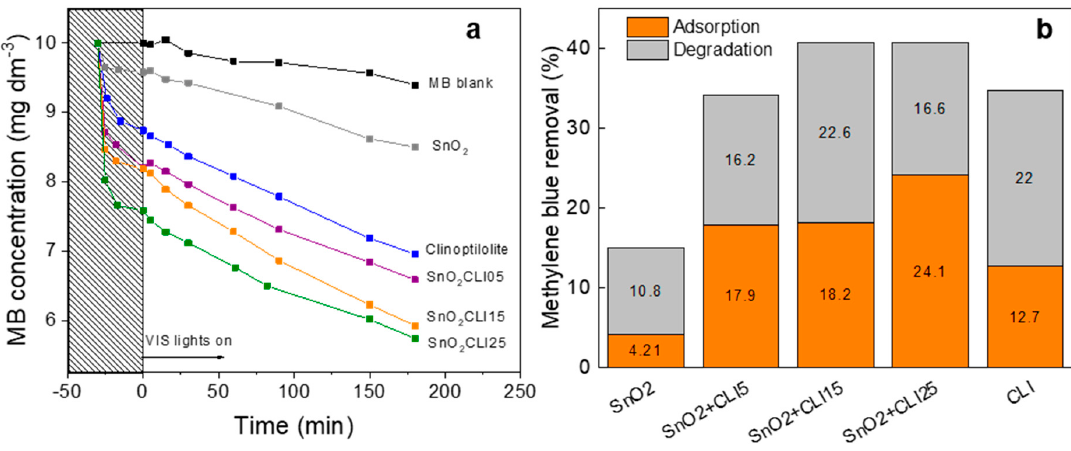
Figure 9. Methylene blue (MB) photodegradation by using CLI, SnO 2 , and SnO 2 -containing clinoptilolite ( a ) and representation of the results with bars showing adsorption and degradation phase ( b ). Reaction conditions: m cat = 10 mg, V = 50 cm 3 , O 2 flow = 25 cm 3 min –1 , T = 22 °C, C 0 = 10 mg dm 3 .